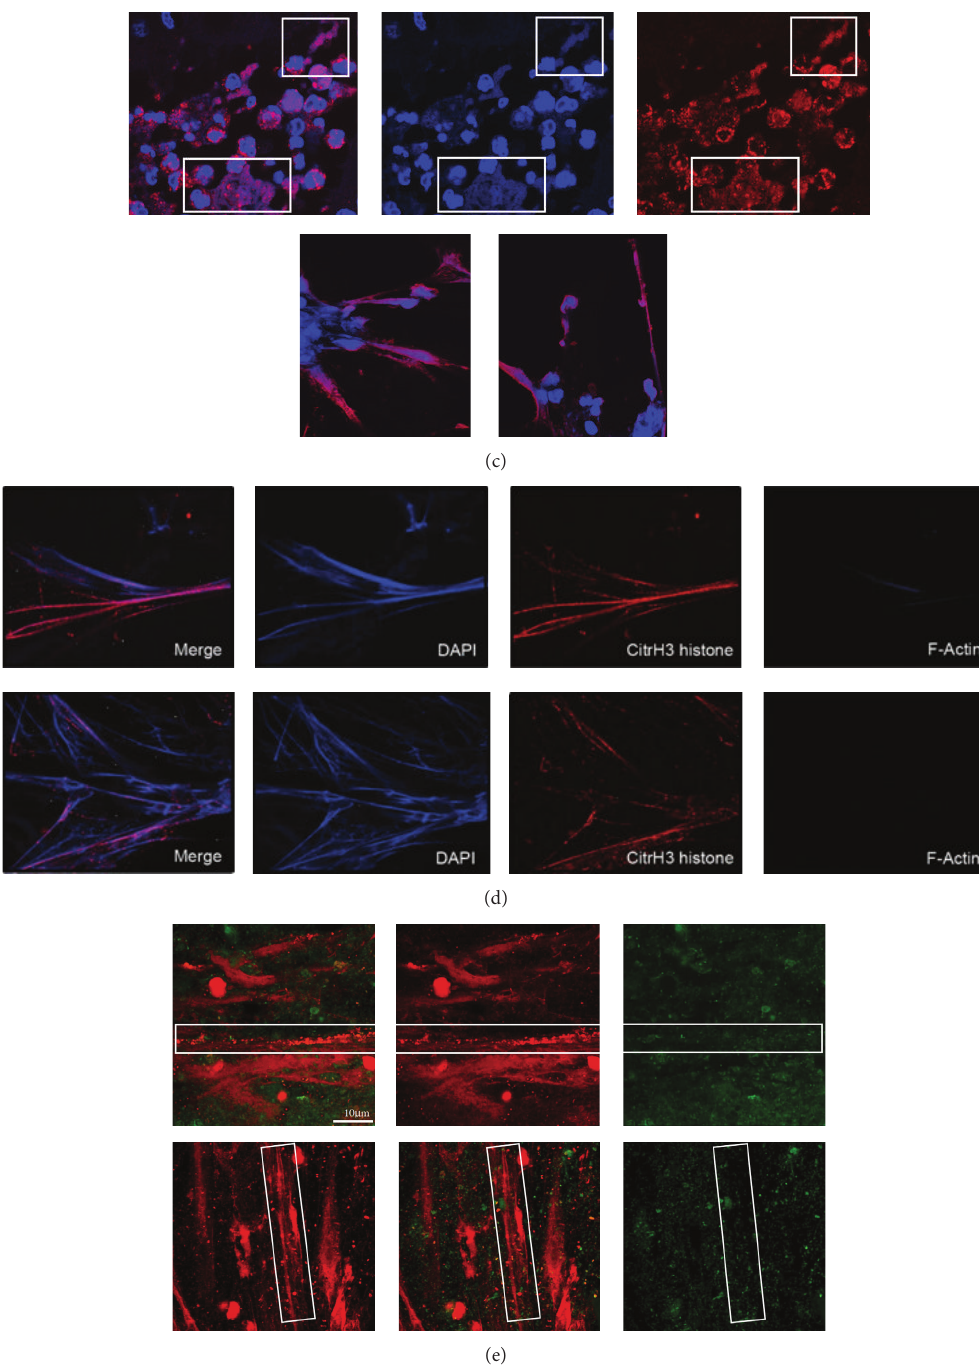
Figure 1: Free NET-like DNA structures in CF lung disease. (a) Immunological characterization of free DNA structures in CF airway fluids by CLSM. Upper two panel rows: NET-like DNA structures in induced CF sputum. Blue: DAPI stains DNA-NET backbone. Red: elastase. Lower two panel rows: Blue: DAPI, red: citrullinated histones. Scale bar: 20 𝜇 m. (b) Ultrastructure of free NET-like DNA structures. Upper and middle panels: SEM images of CF airway fluids. Arrow marks bacteria entrapped in DNA-NET-like structures. Scale bar: 2 𝜇 m; Middle right panel: TEM staining of citrullinated histones in CF airway fluids (sputa). Lower panel: Ultrathin sections of CF airway DNA-NET- like structures. The NETs and the bacterial extracellular polysaccharides are visualized by the ruthenium-red-osmium-tetroxide technique. Bacteria embedded in a dense wickerwork of NETs. Arrowheads mark NETs; asterisk: bacterial extracellular polysaccharide. (c) Upper panel: free DNA structures in CF lung tissue. Red: MPO (as characteristic NET component). Blue: DAPI (DNA). Inlays mark characteristic NET- areas. Lower panel: CF airway NETs in CF BAL fluids. Red: elastase (as characteristic NET component). Blue: DAPI (DNA). (d) Costainings of DAPI, citrullinated histones, and F-actin. Scale bar: 20 𝜇 m. (e) Dead/live staining of CF airway fluids (induced sputum). Free DNA and dead bacteria appear red; vital bacteria appear